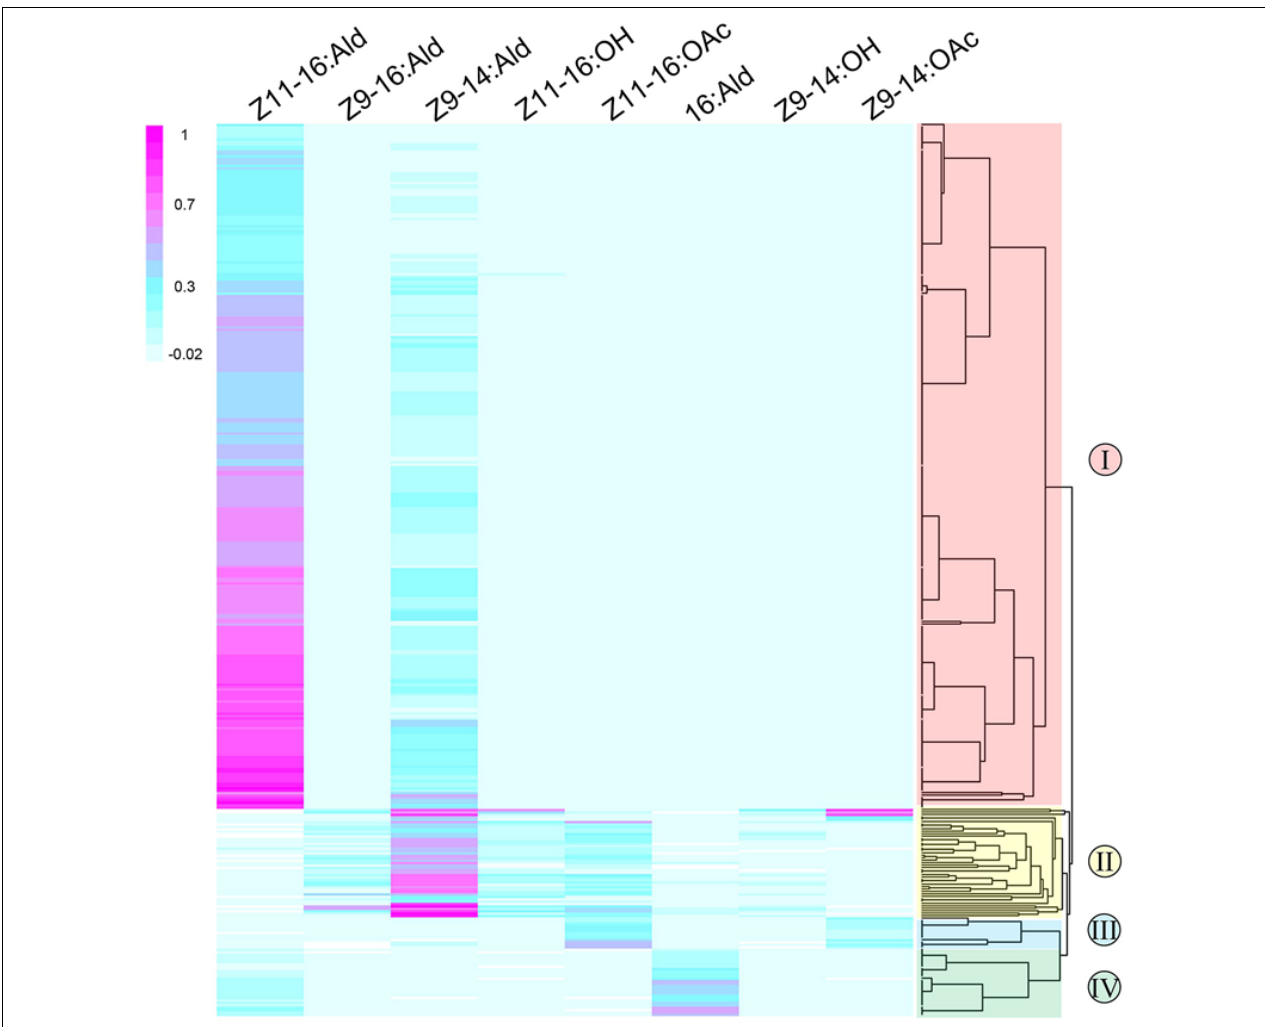
FIGURE 2 | Response profiles of functional ORNs housed in 403 TS in the antennae of male M. separata ( y -axis) in response to four sex pheromone components and four pheromone analogs ( x -axis). The classification dendrogram was generated using the agglomerative hierarchical clustering method, leading to four functional TS types (I, II, III, and IV). Responses are normalized using linear model and color coded for each neuron. Magenta indicates a strong response of ORNs to odorants; blue, weak excitation; light blue, no response; white indicates that spontaneous spiking activity was reduced compared to